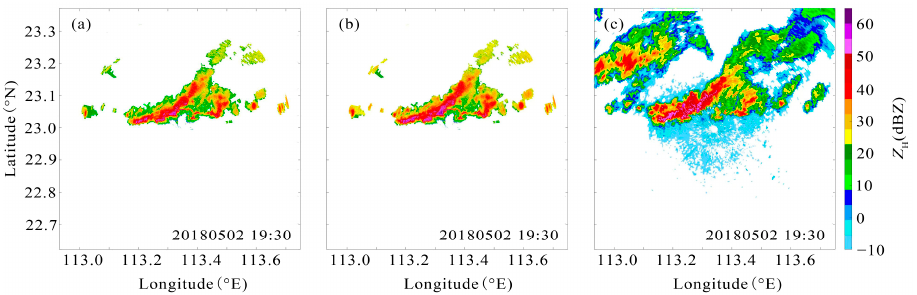
Figure 5. Measurements of Z H from the Panyu PAR ( a ) without attenuation correction and ( b ) after attenuation correction at the 6.3 deg elevation at 19:30 on 2 May 2018; ( c ) Measurements of Z H from the Guangzhou S-band radar at the 6 deg elevation at 19:30 on 2 May 2018.